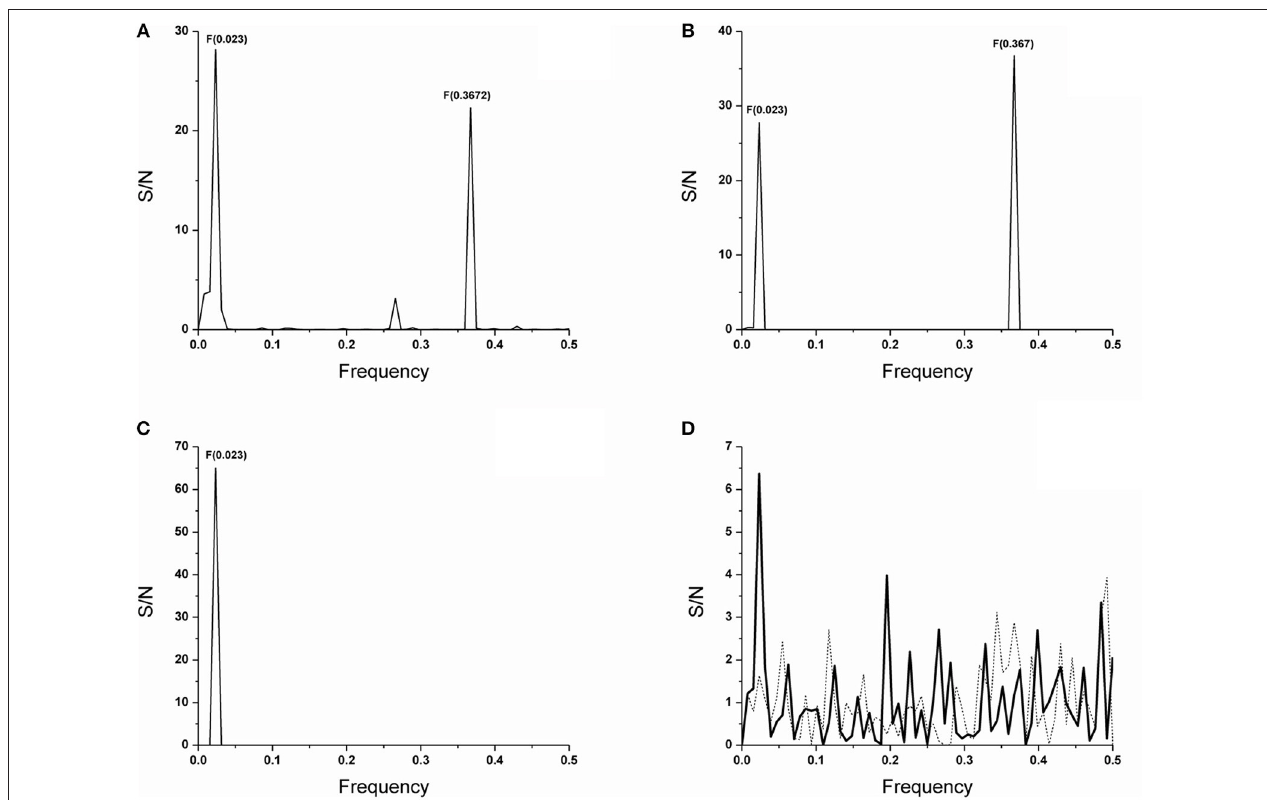
FIGURE 1 | ISM analysis of the V germline genes and antibody VH domain protein sequences. The CIS of the V germline genes segments of VH1, VH11, S57(VH31) and MRL-DNA22 which shows characteristic F(0.367) relevant for the biological activity here followed and activity irrelevant F(0.023) (A) . The CIS of the VH domains of antibodies 74.c2 encoded by the V gene segment VH11, a member of the VH7 (S107) gene family, 17s-c2 encoded by the V gene segment S57(VH31) and 17s.83, 17s-c3, 111.185 and 165.27 encoded by V gene segment MRL-DNA22 of the VH1 (J558) gene family (B) . CIS of all anti-DNA antibodies which in individual spectrum does not express F(0.367) (C) . The IS of the preimmune natural polyreactive autoantibodies which use V gene segments from VH2 (Q52) gene family such as D23 VH domain (___) and superimposed IS of the E7 VH domain (…...) (D) . The abscissa represents the frequencies from the Fourier transform of the sequence of electron-ion interaction potential (EIIP). The lowest frequency is 0.0 and the highest is 0.5. The ordinate represents the signal to noise ratio (S/N) corresponding to each frequency component in the informational spectrum (IS).